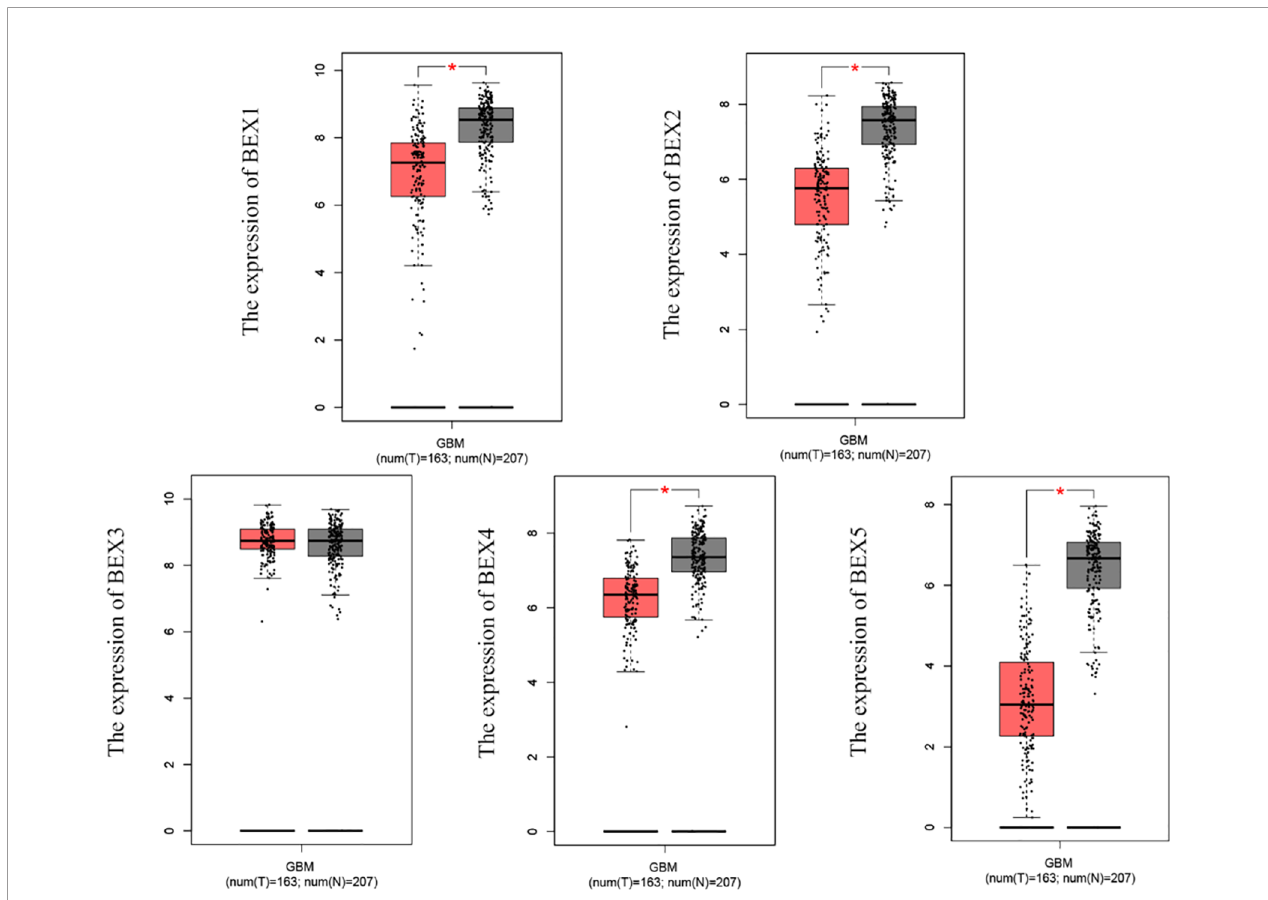
FIGURE 1 | The mRNA expression of BEX family in GBM based on TCGA database and GTEx database. GBM, glioblastoma multiforme; TCGA, The Cancer Genome Atlas; GTEx, Genotype-Tissue Expression ns, p ≥ 0.05; *p< 0.05; **p<0.01;